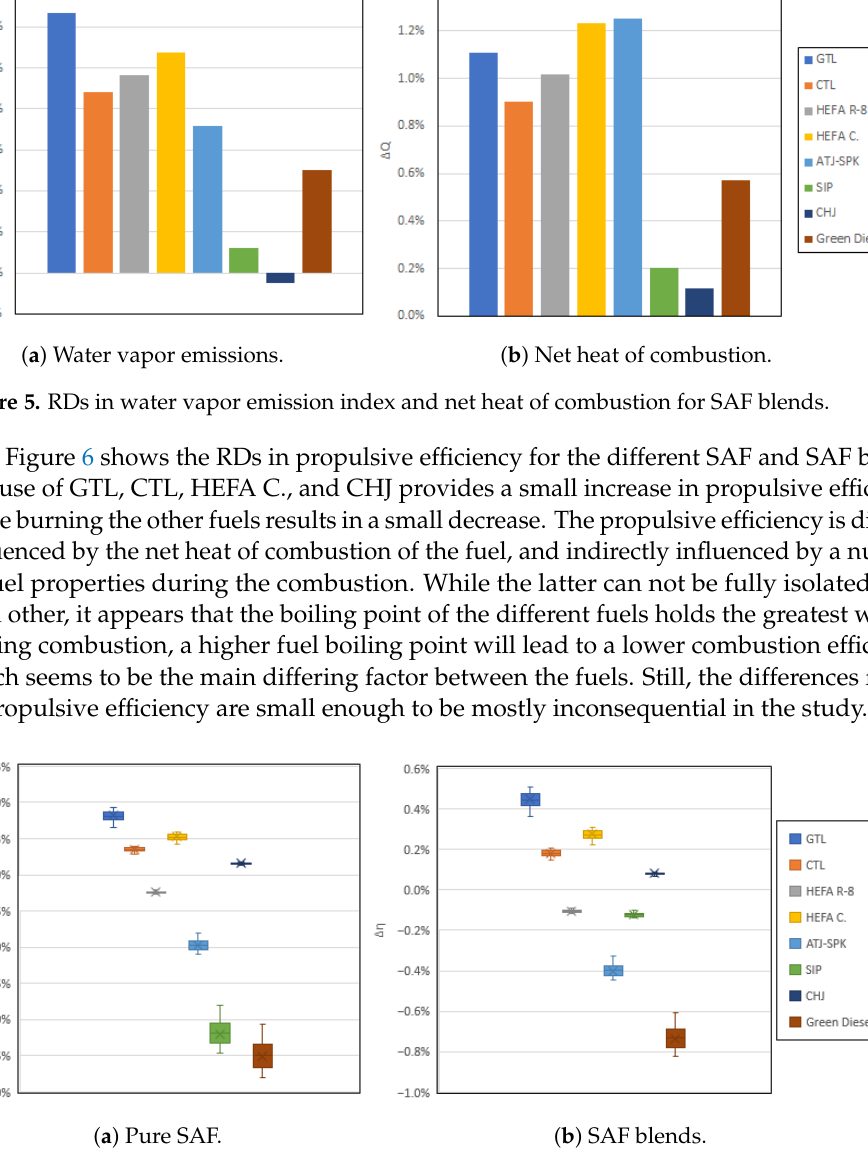
Figure 6. RDs in propulsive